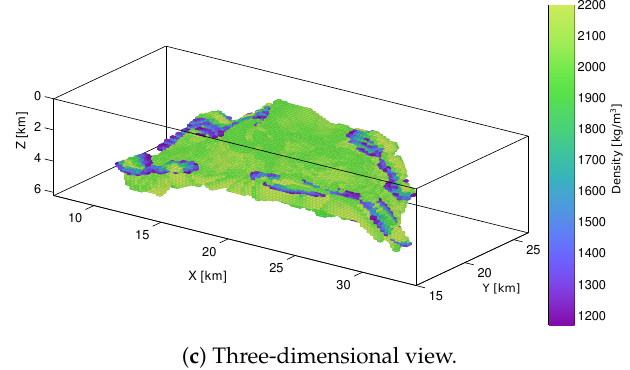
Figure 33. Inverted gradiometric model for the salt body.